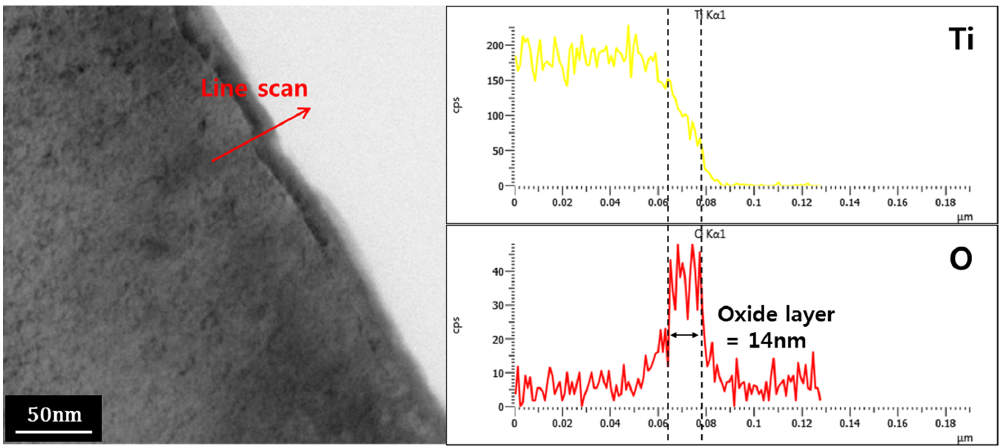
Figure 3. Surface microstructure of ball-milled TiH 2 observed by TEM. Line scan was performed to analyze the thickness of oxide layer.